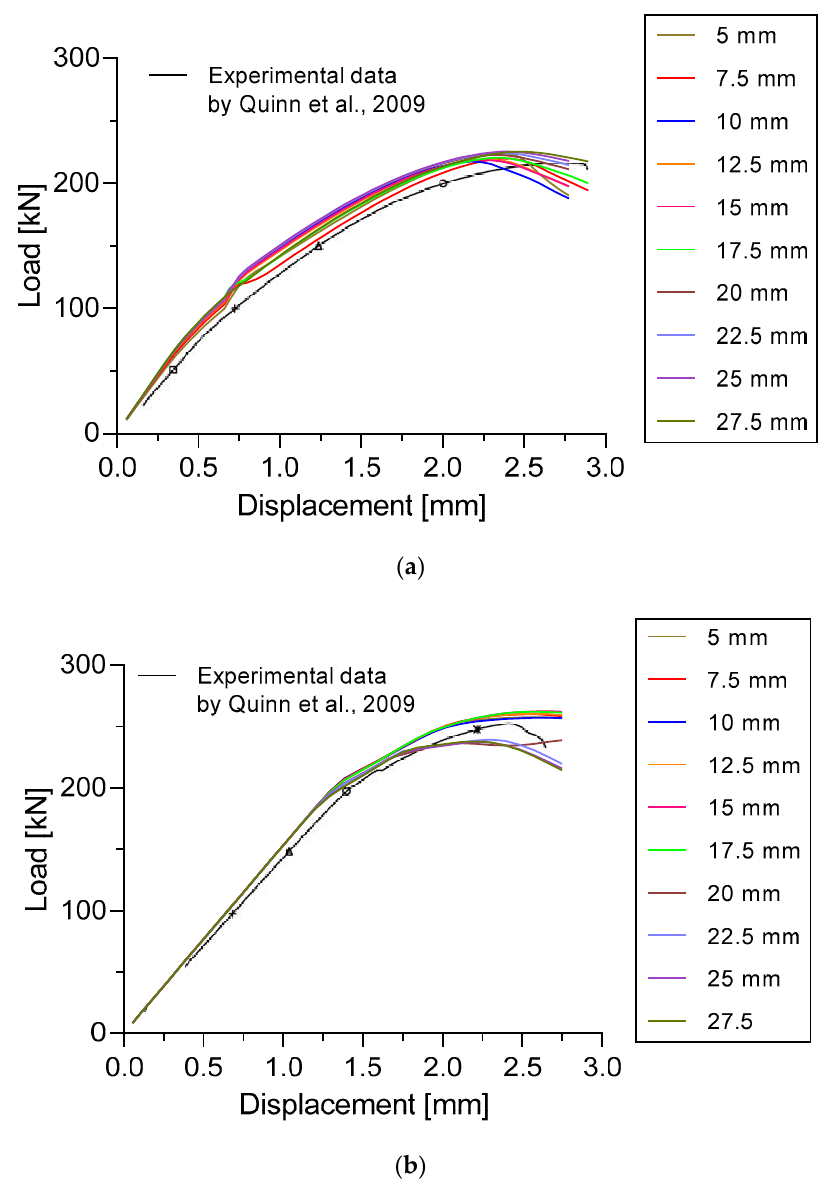
Figure 9. Load versus displacement curves based on comparison with laboratory experiment by Quinn et al. [41]. ( a ) Specimen A and ( b ) Specimen B.